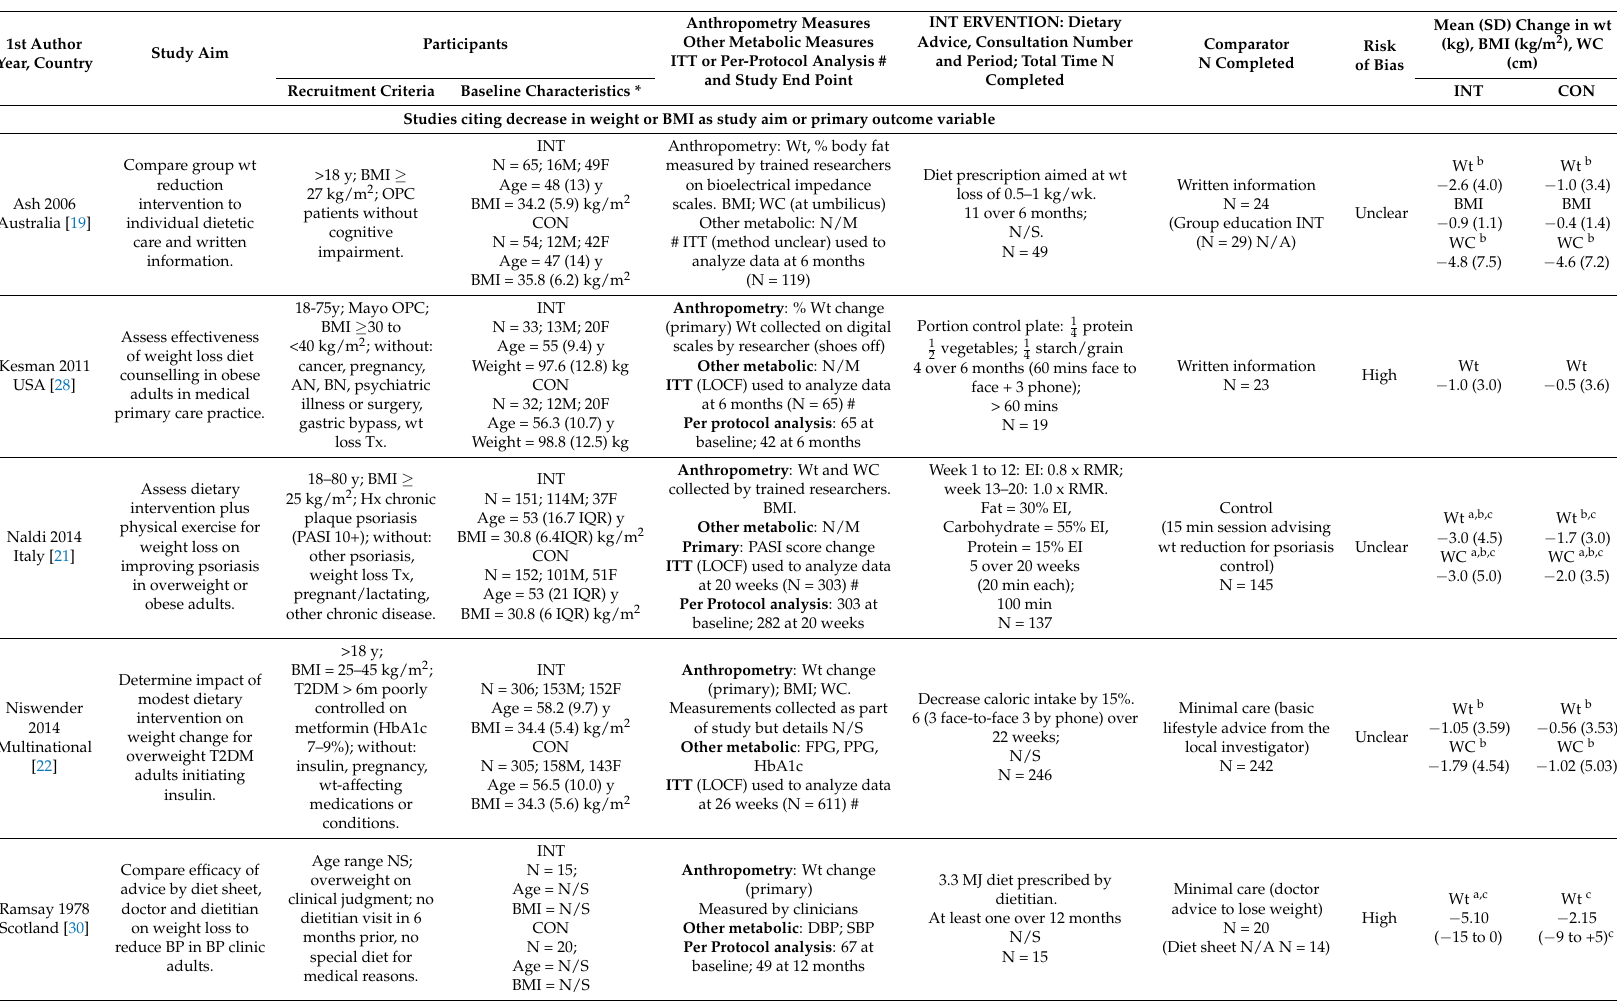
Table 2. Details of the included randomized controlled trials (RCTs) assessing anthropometry: the measures and